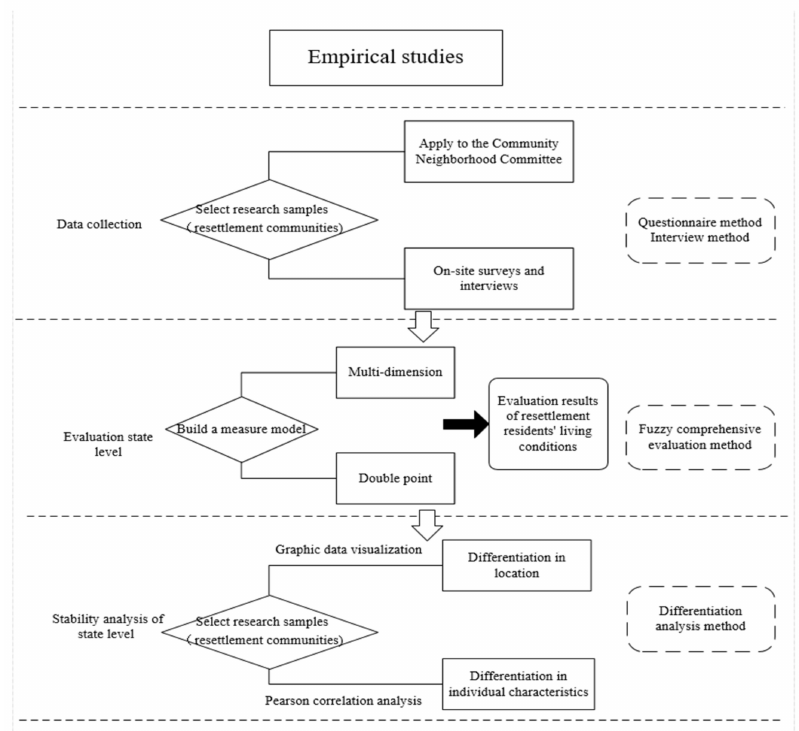
Figure 2. Flow-diagram of empirical